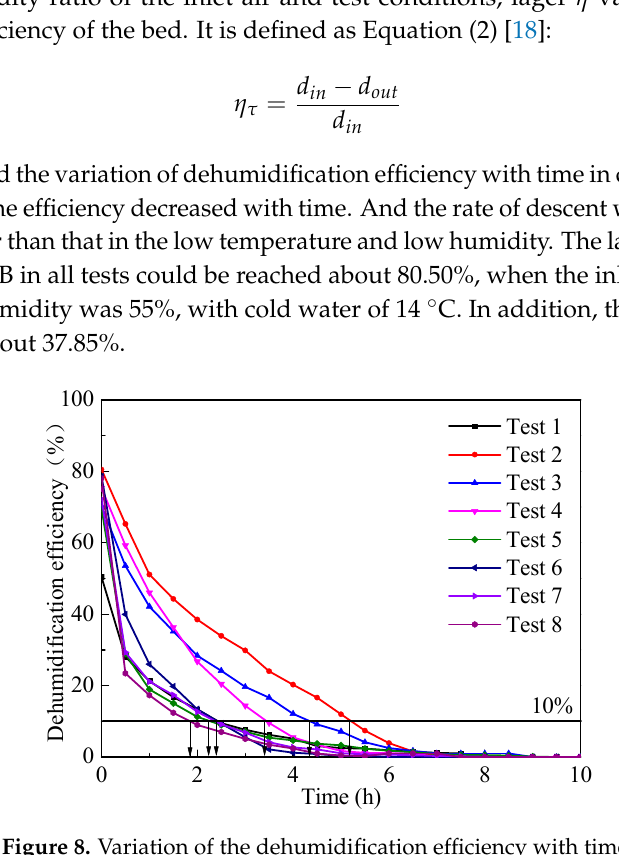
Figure 8. Variation of the dehumidification efficiency with time.